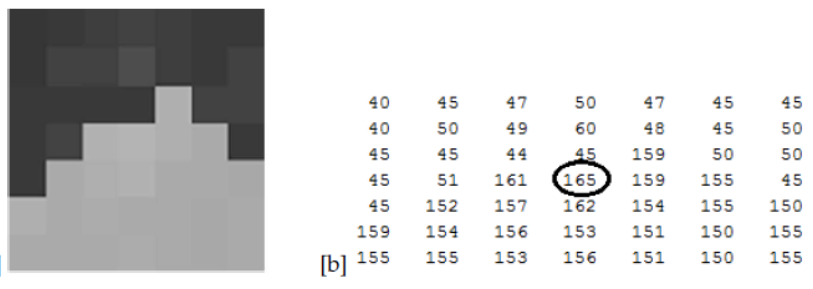
Figure 5. ( a ) image on a grayscale. ( b ) Matrix of image.